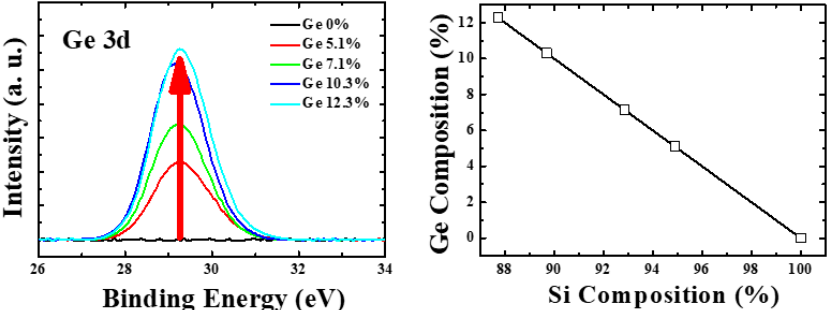
Figure 3. ( left ) X-ray photoelectron spectrum (XPS) of Ge 3 d peak; ( right ) Ge and Si component ratio of the poly-Si 1 − x Ge x thin film.